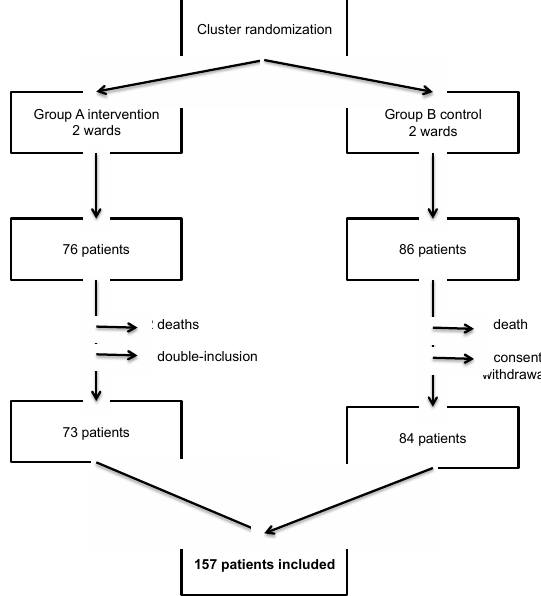
Figure 2. Enrollment flow